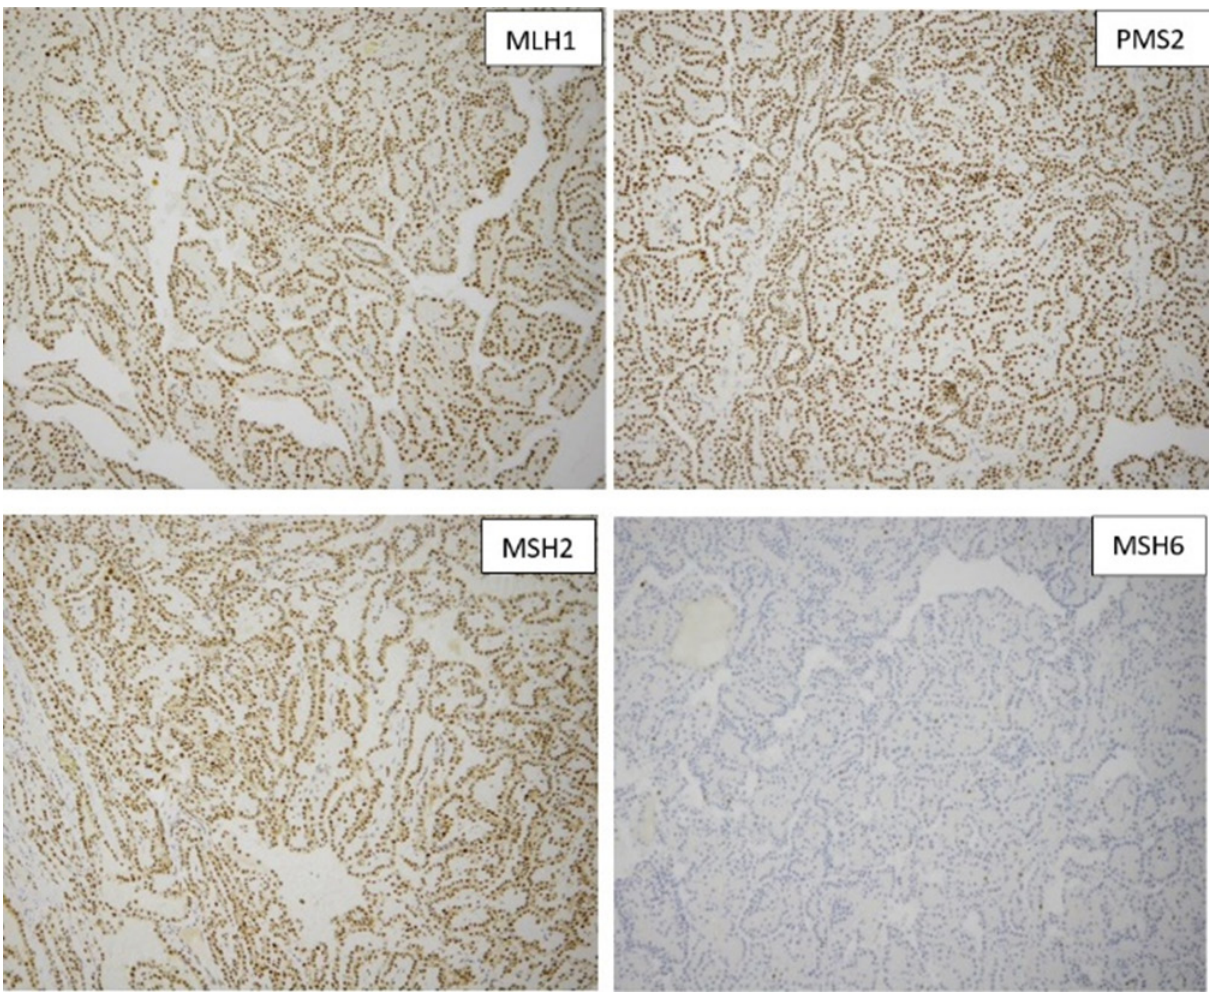
Figure 5: Immunohistochemical stain for mismatch repair proteins showing loss of expression of MSH6 and preserved nuclear expression of MLH1, PMS2, and